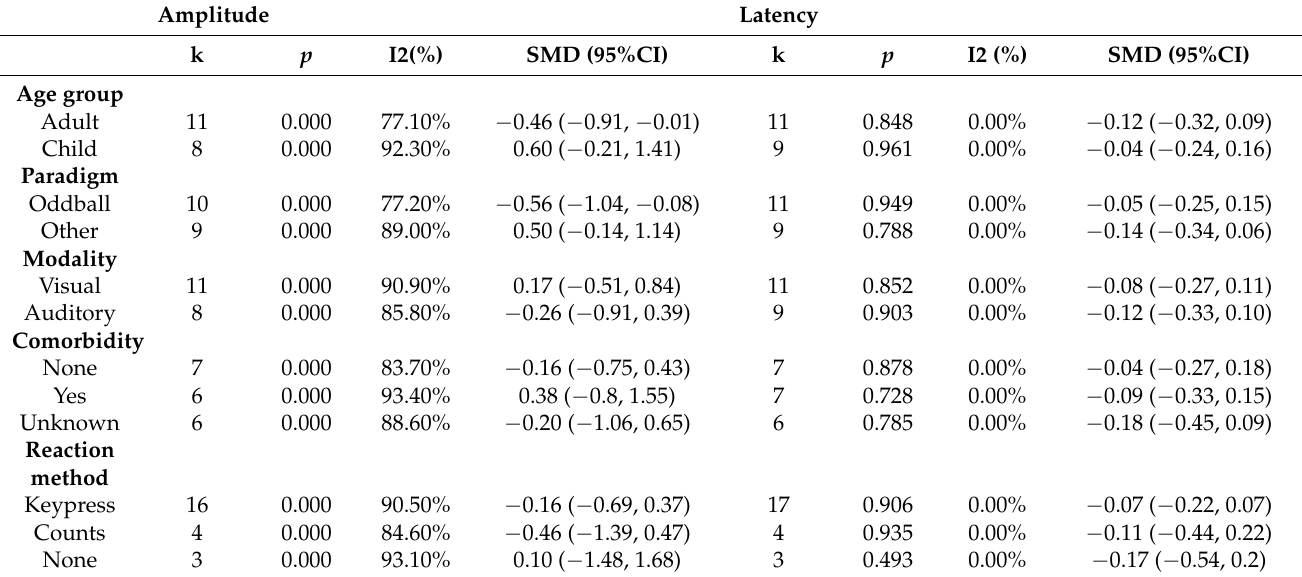
Figure 9. Subgroup analysis of P3b amplitude in TD patients and HCs (adults and children). SMD: Standard Mean Difference; CI: confidence interval. Table 2. P3b subgroup